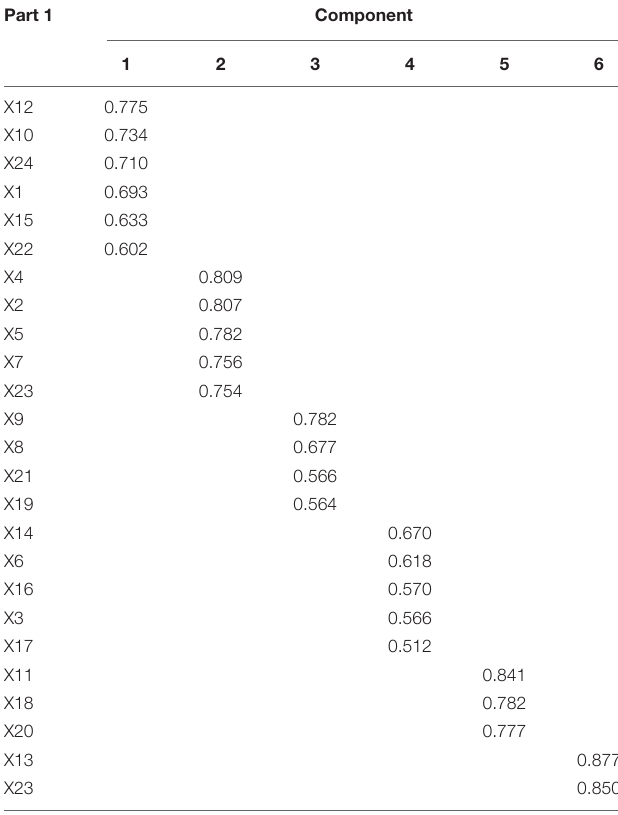
TABLE 9 | Factor load matrix after